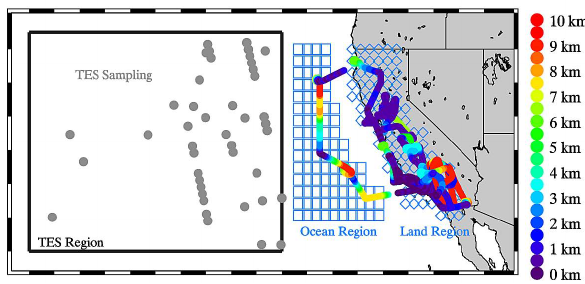
Fig. 1. Locations of observational data sets and modeling regions: Flight tracks of the boundary layer segment on 22 June 2008 and the flights over California are color coded by altitude. The ocean and land region over which additional model statistics (AVGRegion and AVGRegionTime) are performed are indicated by blue squares and blue diamonds, respectively. The TES sampling locations are shown by grey circles and the TES region is outlined by the black